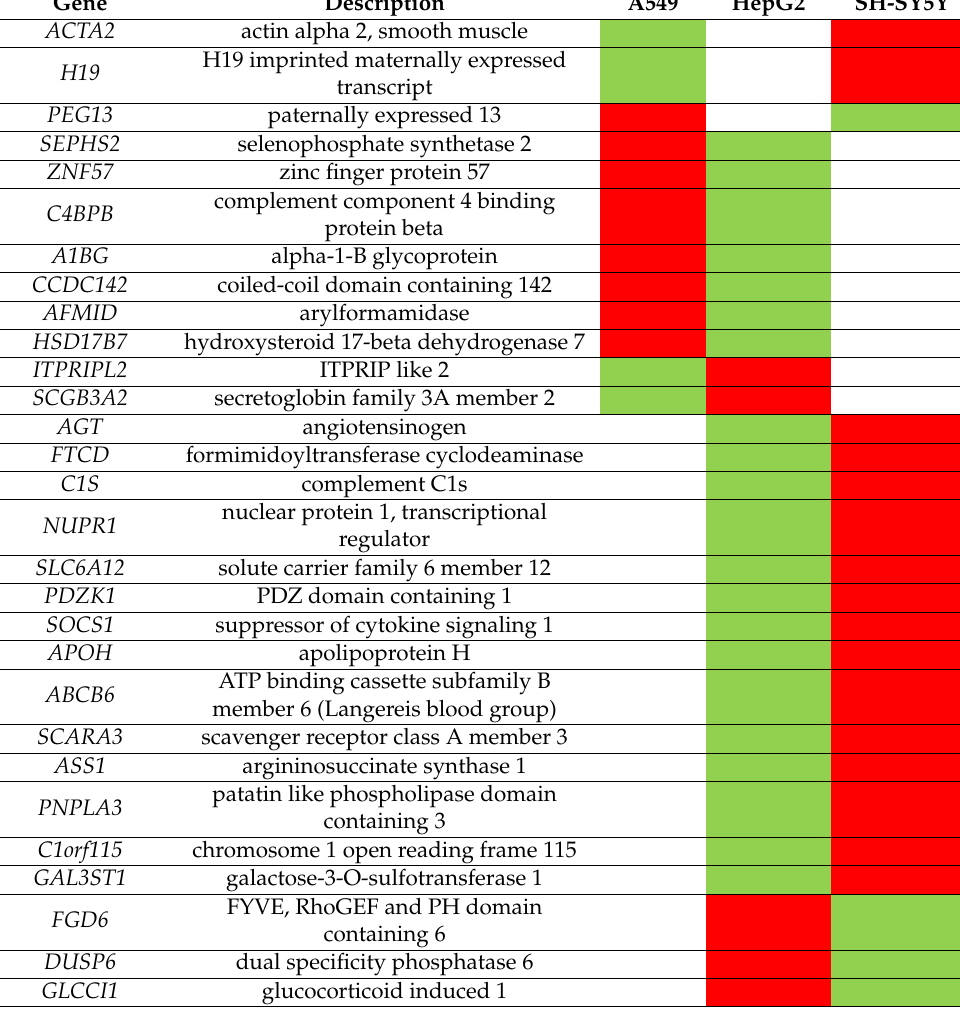
Table 2. Genes in common in HepG2, A549 and SH-SY5Y cells displaying different patterns of expression emerged from the two by two comparison. Note that colors are indicative of upregulation (red) or downregulation (green) only, not of the level of expression. Gene Description A549 HepG2 SH-SY5Y ACTA2 actin alpha 2, smooth